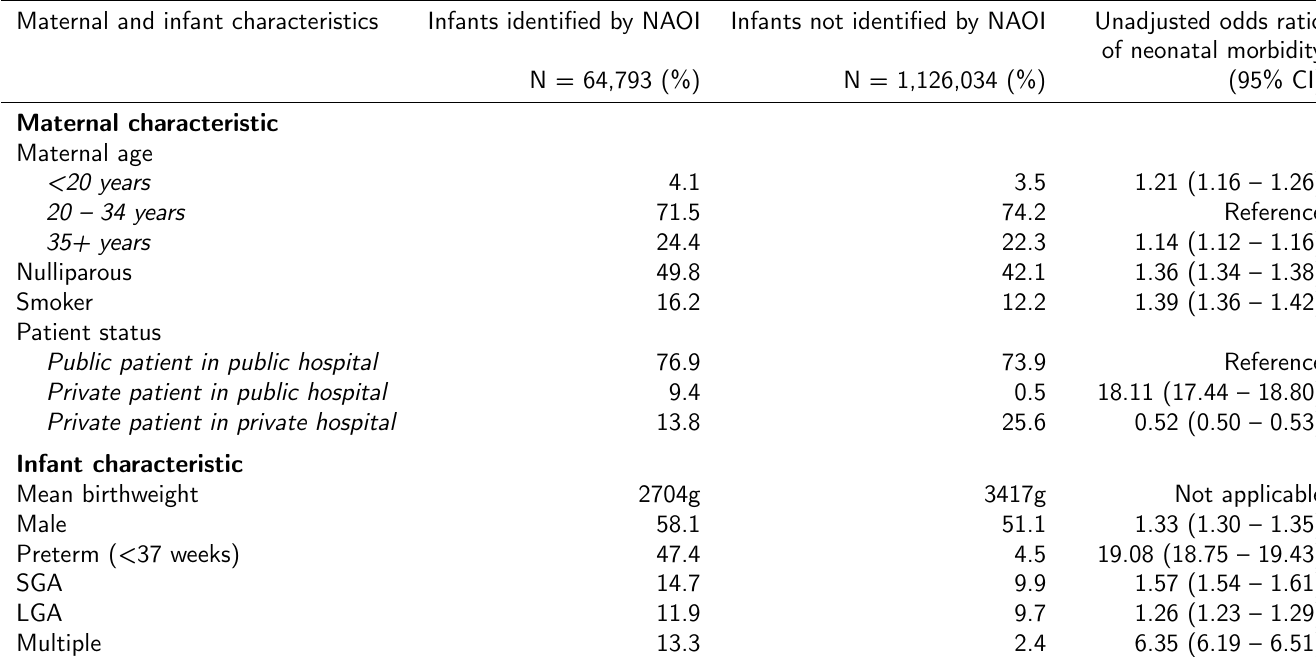
Table 3: Frequency of infants with and without severe or medically significant morbidity, as identified by the neonatal adverse outcome indicator (NAOI) and association of neonatal morbidity with maternal and infant